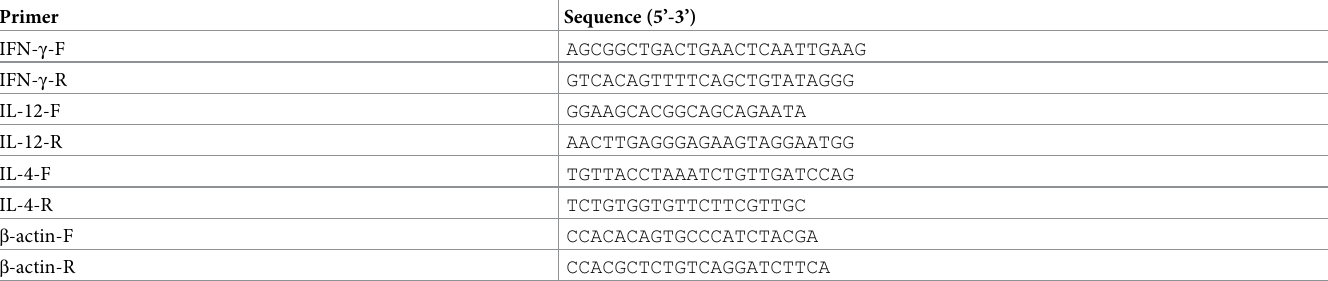
Table 1. Primers used in the qRT-PCR